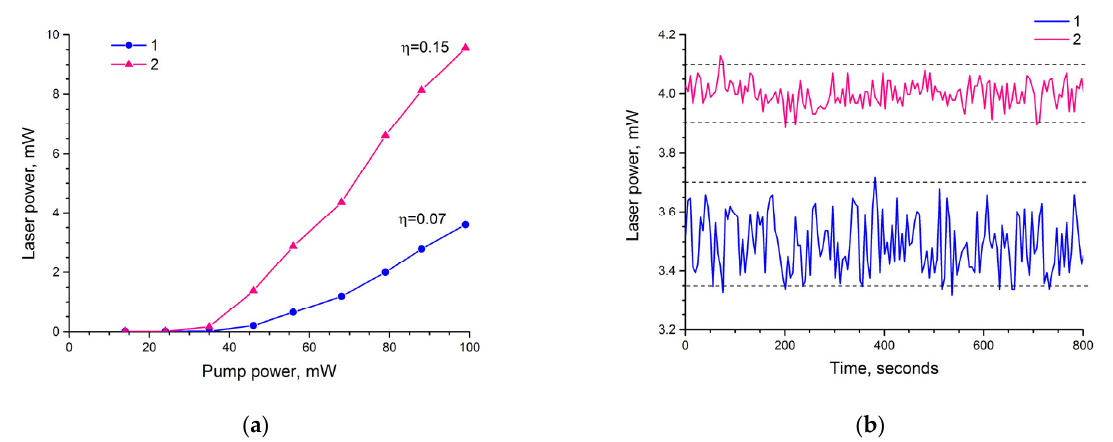
Figure 7. Dependences of the laser output power on the pump power ( a ) and time ( b ) for the configurations of a simple 1.8 m long “random” resonator (“1”) and the same resonator modified with the separate FBG (“2”).